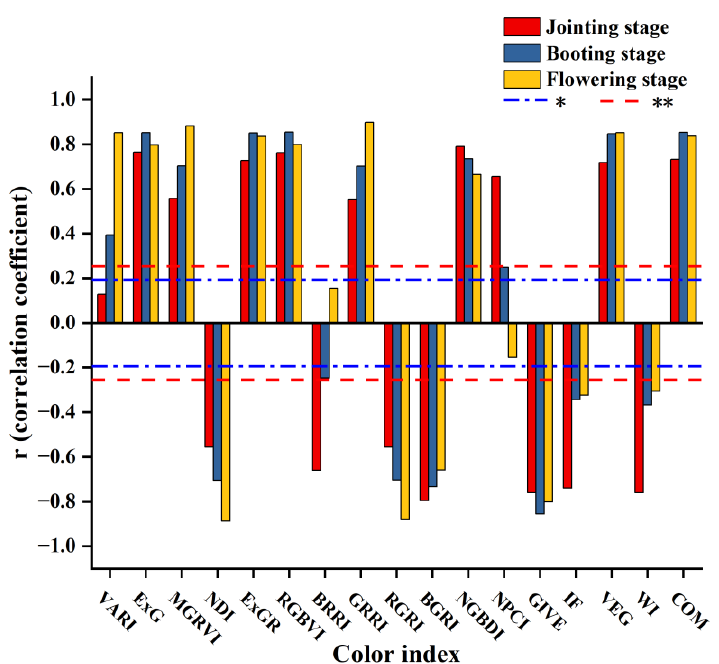
Figure 5. Correlation coefficient (r) between CIS and AGB. Note: * indicates significance at p < 0.05, and ** indicates significance at p < 0.01.